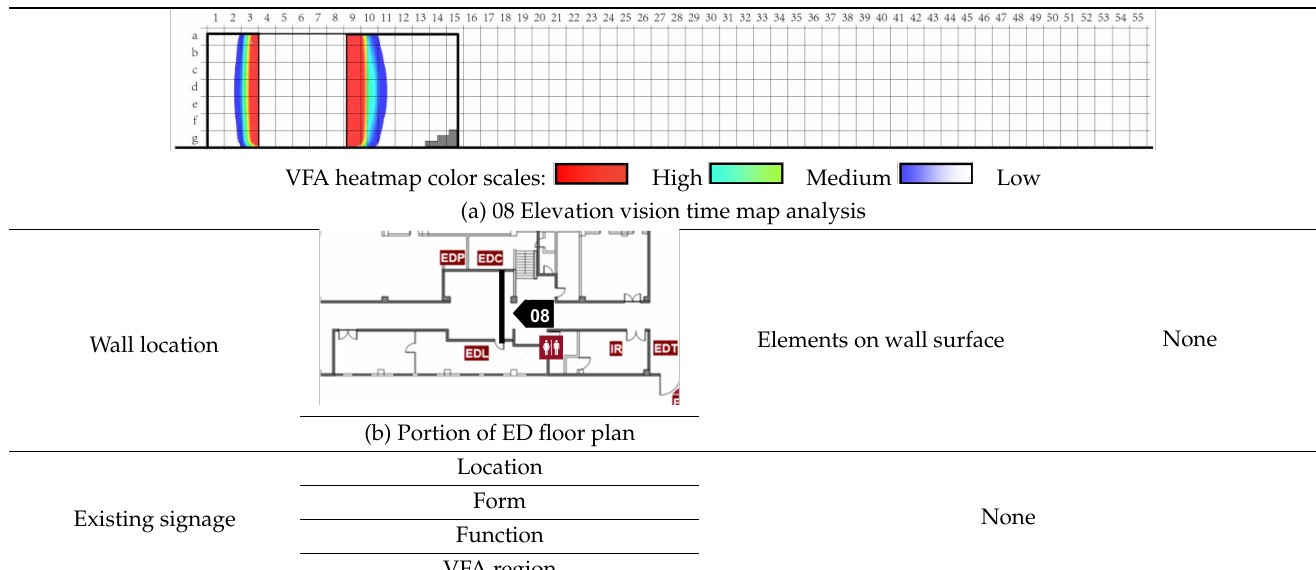
Table 12. 08 Elevation comparative